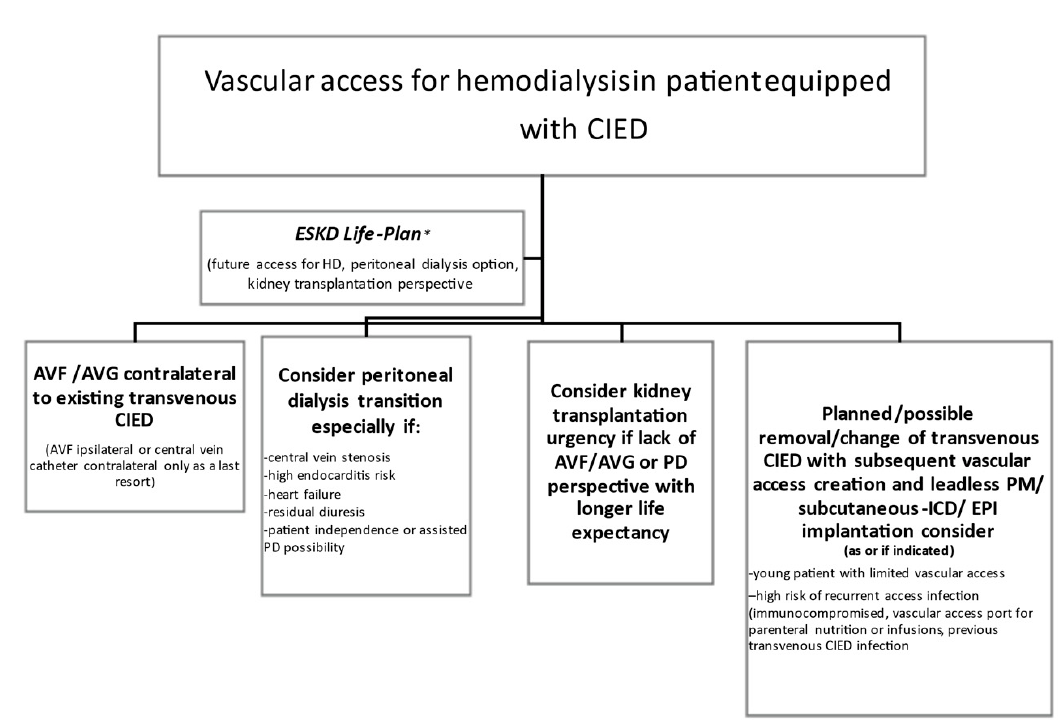
Figure 2. Decision-making on vascular access in an ESKD patient with CIED. AVF—arteriovenous fistula, AVG—arteriovenous graft, ESKD—end-stage kidney disease, CIED—cardiovascular implantable electronic device, ICD—implantable cardioverter-defibrillator, PD—peritoneal dialysis, EPI—epicardial, PM—pacemaker. * ESKD Life-Plan approach in concordance with the KDOQI